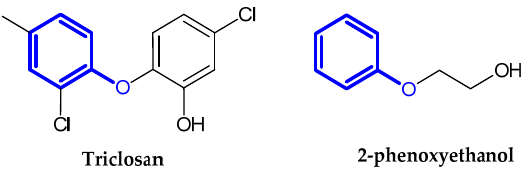
Figure 11. Auxiliary substances bearing phenoxy moiety.